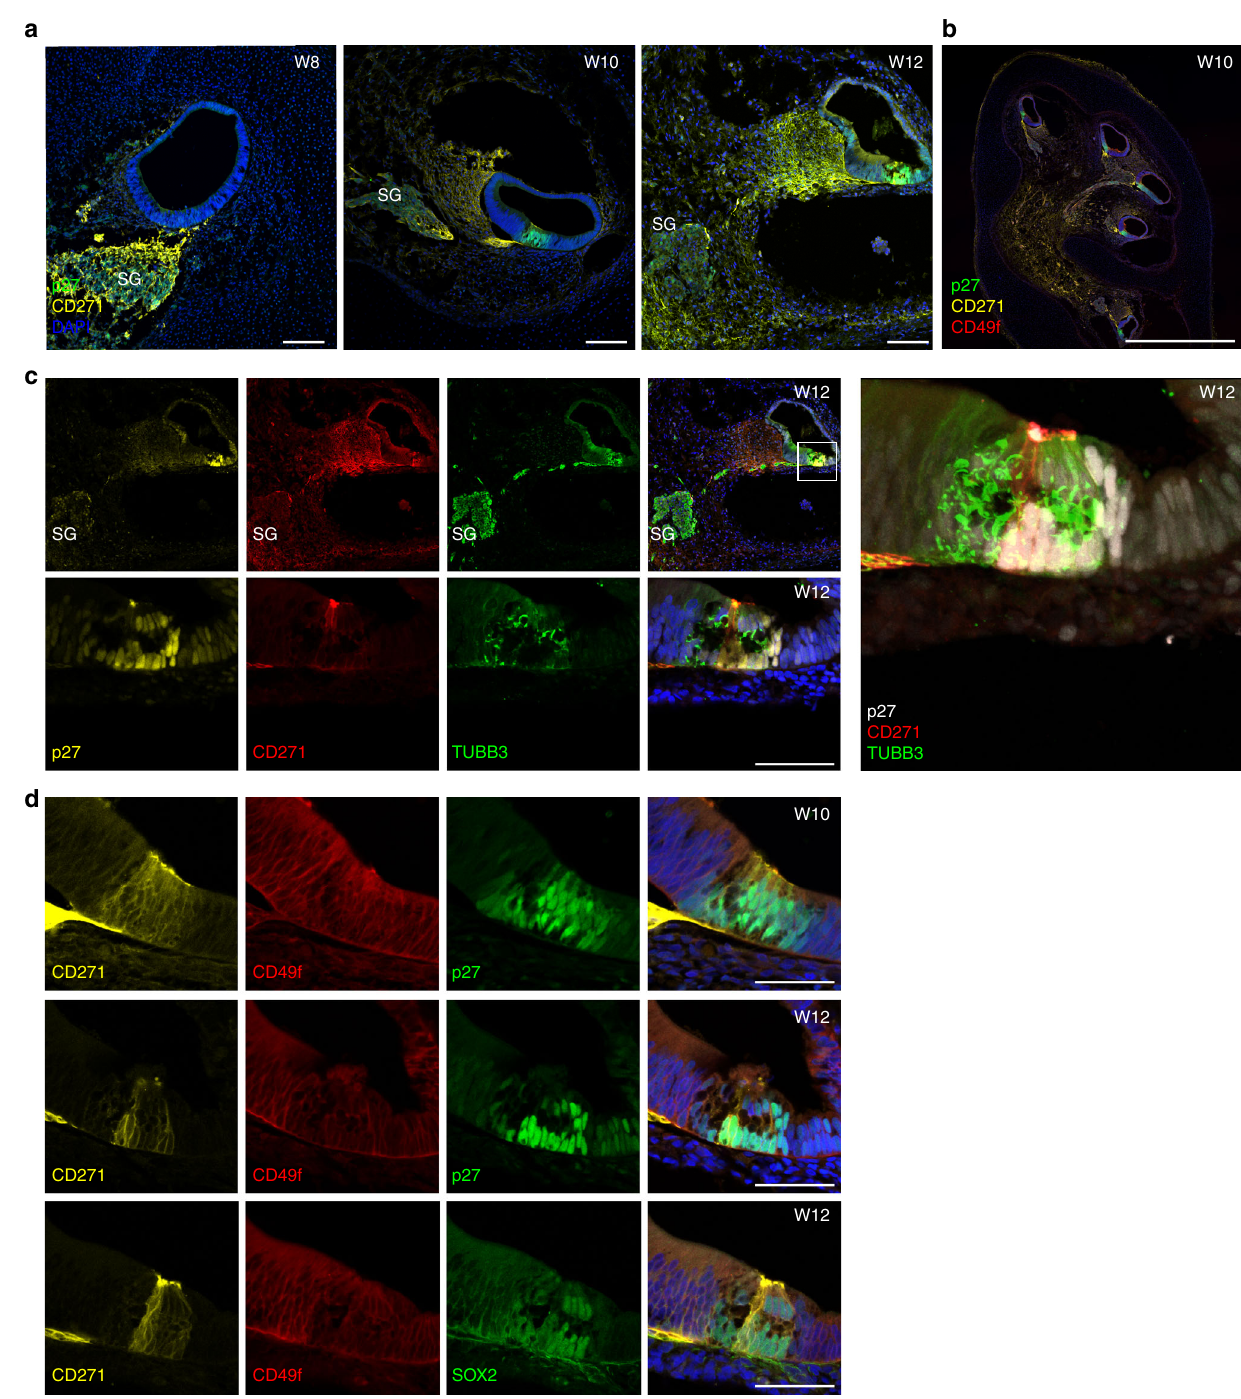
Fig. 2 CD271 is expressed by epithelial cells within the prosensory domain. a Immunostaining for CD271 and p27Kip1 at three stages of development (W8 (E1202), W10 (E1201), and W12 (E1210)). Basal turns are shown. Scale bar = 100 μ m. b Representative modiolar overview section immunolabeled with antibodies to p27Kip1, CD271, and CD49f (E1201, W10) scale bar 1 mm. c CD271, β III Tubulin (TUBB3), and p27Kip1 at W12 of development. Overview pictures and higher magni fi cations are shown. Scale bars = 100 μ m (top) and 50 μ m (bottom). The enlarged right panel shows the merged confocal Z- stacks projected into a single image. d CD271, p27Kip1, SOX2, and CD49f immunolabelings at W10 (E1201) and W12 (E1210). Scale bars = 50 μ